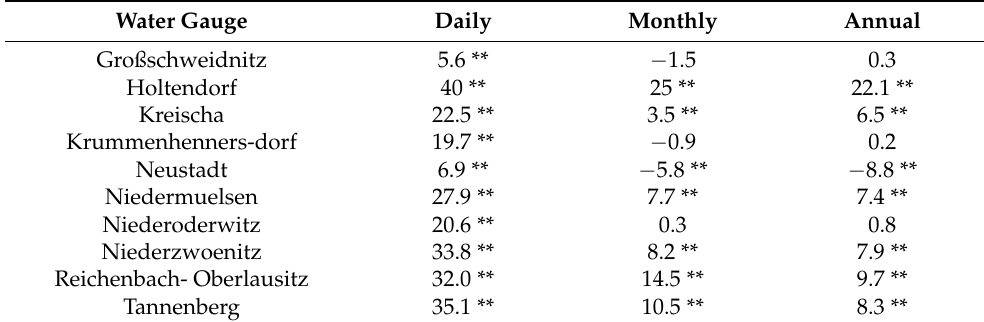
Table 3. Precipitation difference for the study catchments on the different time scales of gauge versus radar using Wilcoxon–Mann–Whitney statistics test.